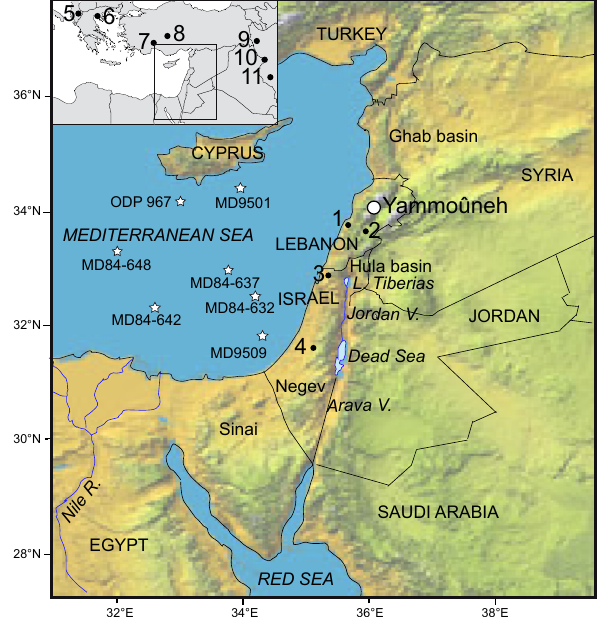
Fig. 1. The Levant in the eastern Mediterranean region. Location of the Yammoˆuneh basin and of sites cited in the text. For terrestrial records, 1: Jeita Cave; 2: Aammish marsh; 3: Peqi’in Cave; 4: